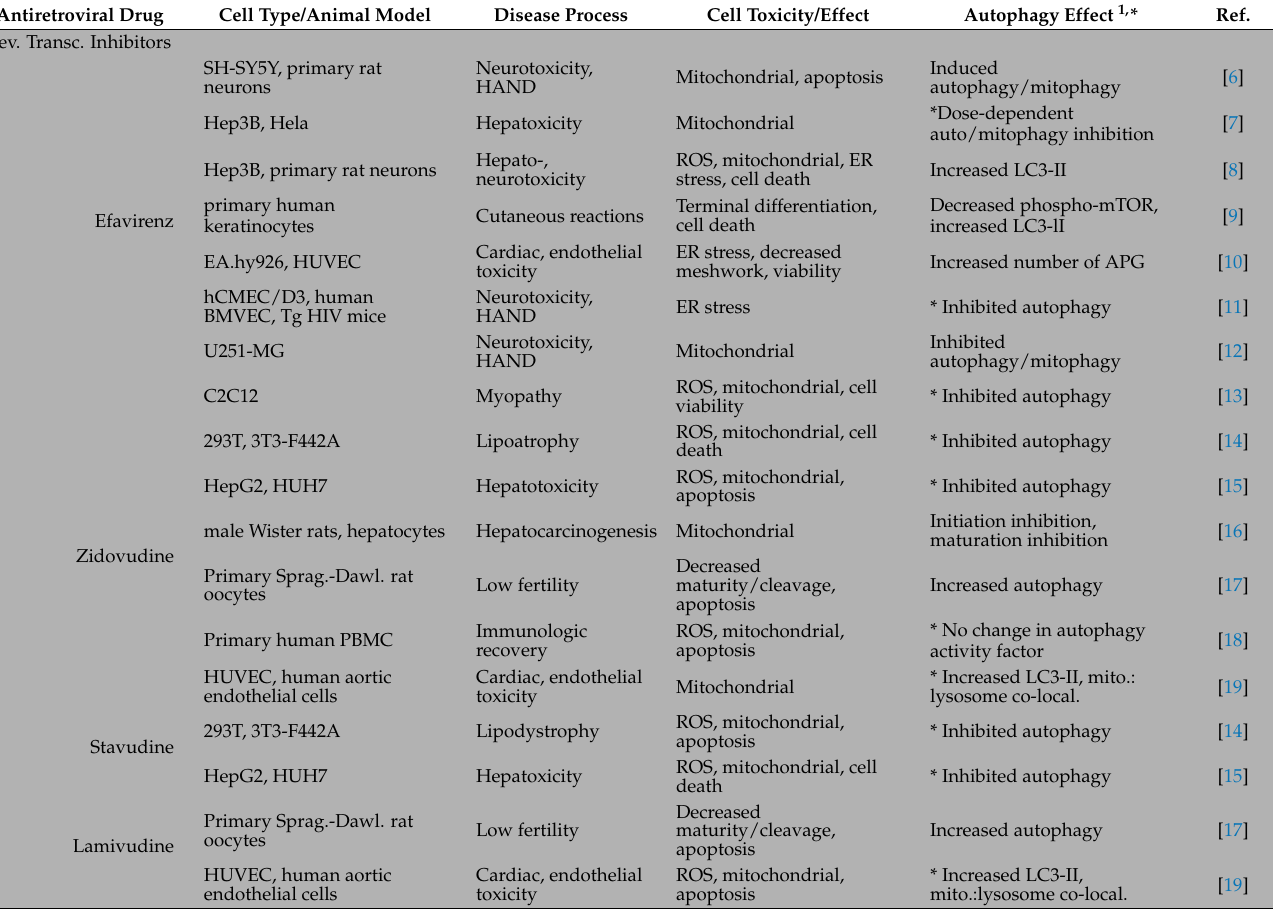
Table 1. Overview of reviewed